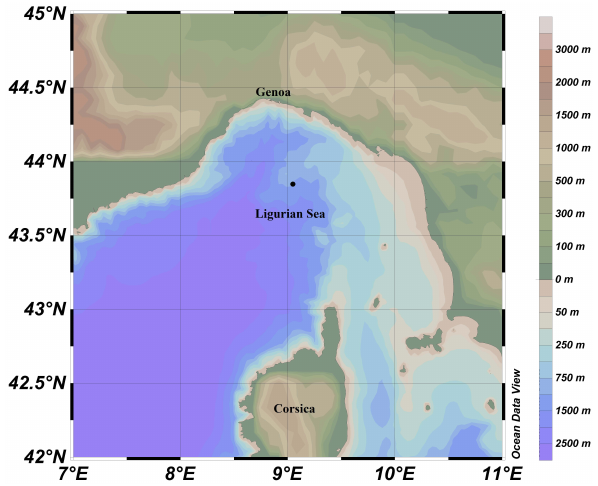
Fig. 1. Bathymetry and horography of the Ligurian region. Black dot corresponds to the mooring